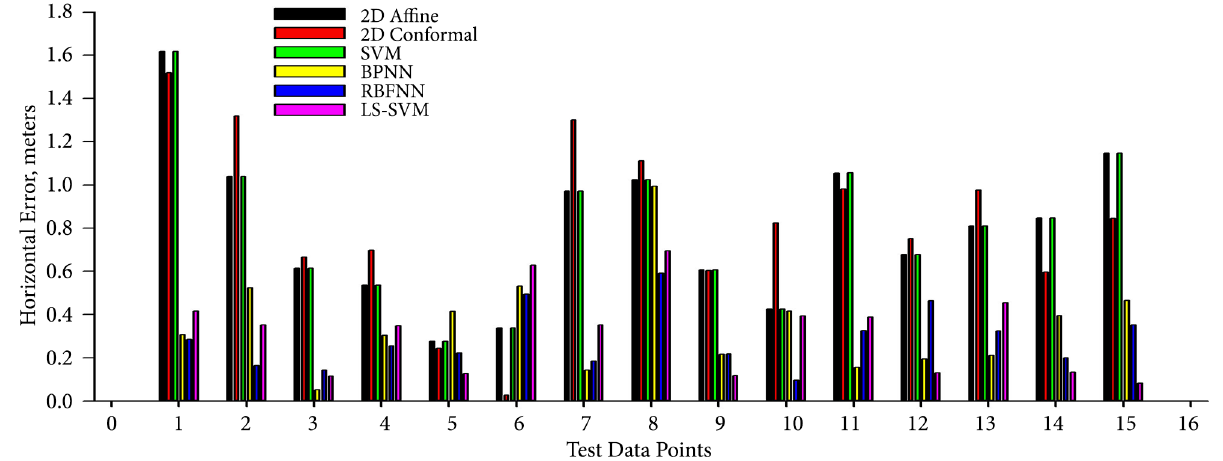
Figure 5. The horizontal positional error for the test